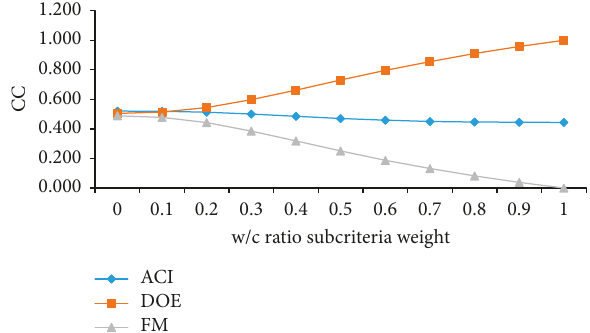
Figure 5: Sensitivity analysis of mix design methods with respect to w/c ratio